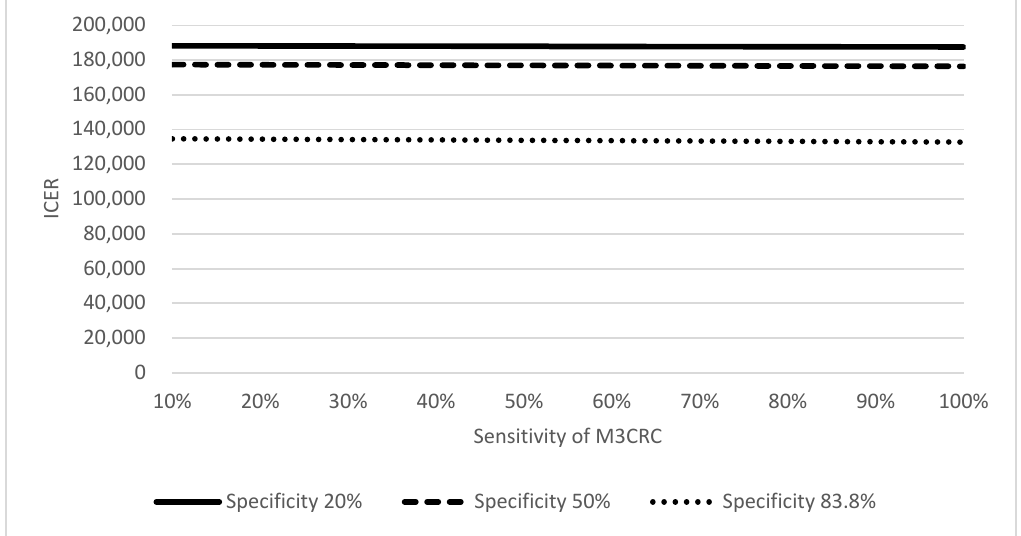
Figure 4. Two-way sensitivity analysis on the sensitivity and specificity of M3CRC. M3CRC was more cost-effective than direct colonoscopy as a primary screening tool. This was not affected much by the cost of colonoscopy. At the range of USD 305 to USD 2000 per colonoscopy, ICER of M3CRC remains lower than that of colonoscopy (Figure 5).